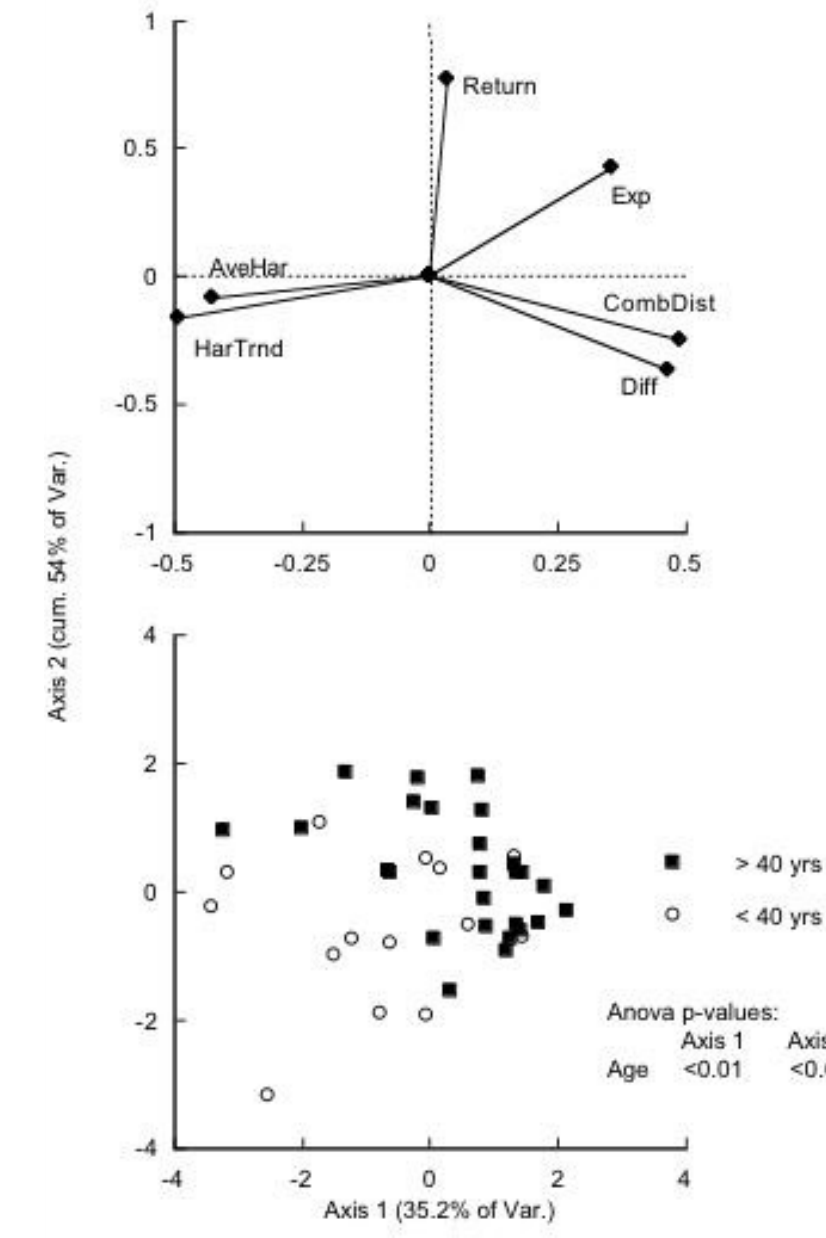
Fig. 2. On top is a vector diagram of the principlal components analysis (PCA) ordination loading factors along Axes 1 and 2. Axis 1 is related primarily to aspects of mangrove scarcity. Axis 2 relates to harvesting intensity. The vector labels refer to the variables in Table 2. On the bottom is the PCA ordination of the 40 interview subjects based on the six response variables in Table 2. The labels indicate whether the subject was younger or older than 40 yr of age. ANOVA values are reported for the effects of urban/rural status and age on PCA Axes 1 and 2